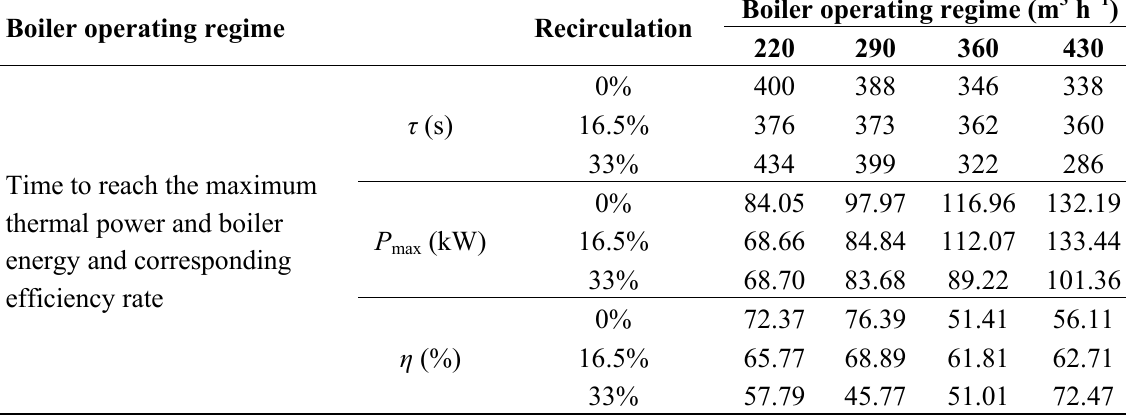
Table 6. Maximum boiler thermal power and corresponding boiler energy efficiency